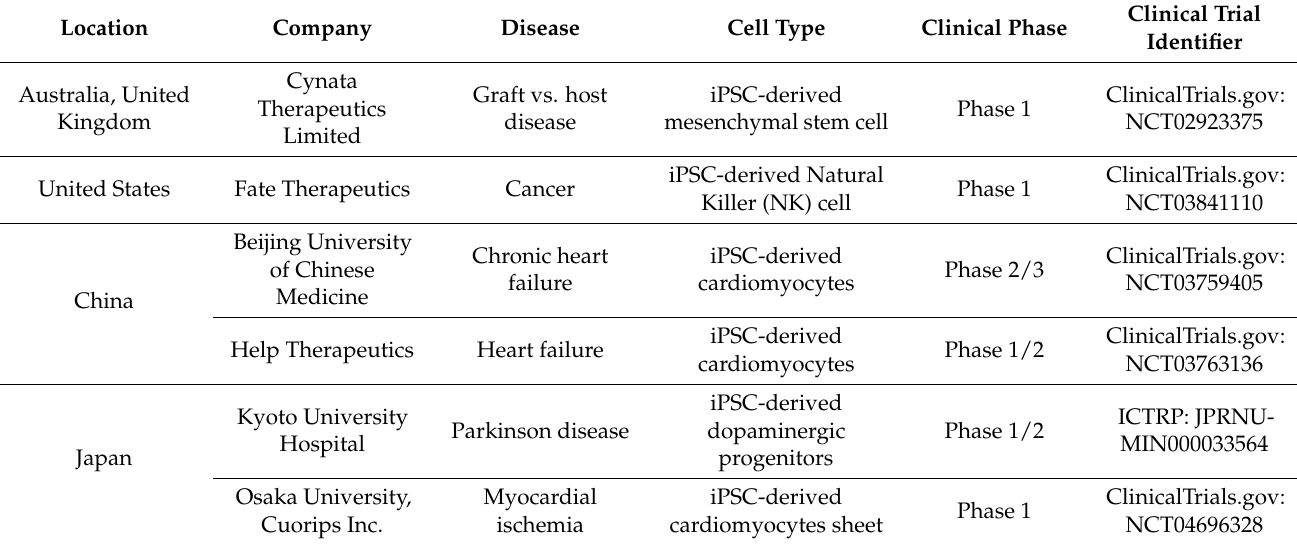
Table 1. Current iPSC-based clinical trials (as of